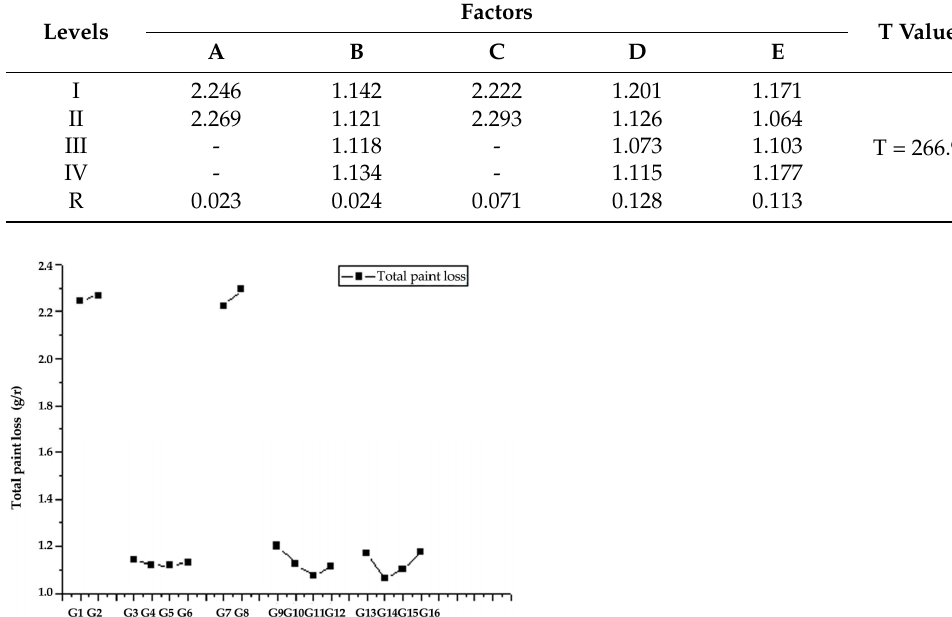
Figure 5. Change trend chart of factor and level for the effect of adhesion of paint film. Using Didebao primer in the pretreatment stage contributes to the paint film